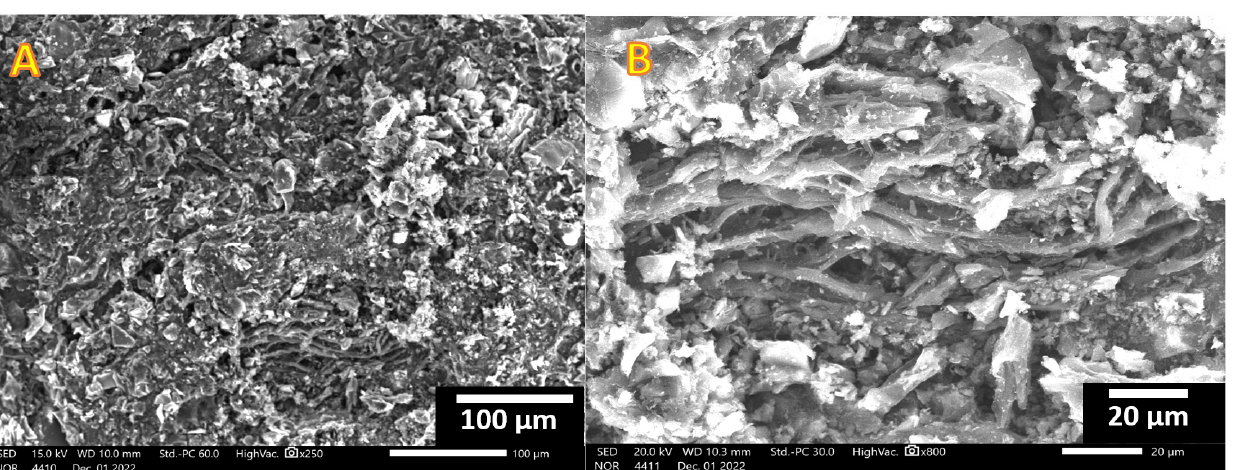
Figure 3. Low; ( A ) and high; ( B ) SEM magnifications for the obtained rice husk activated carbon using KOH/H 3 PO 4 combined activation agent.